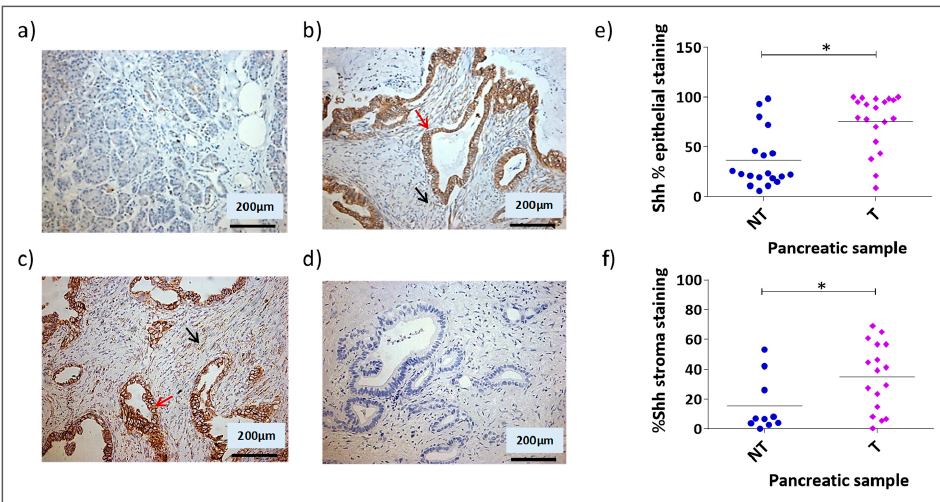
Figure A1. Shh expression in normal and tumour pancreatic tissues. 19 paired normal and tumour